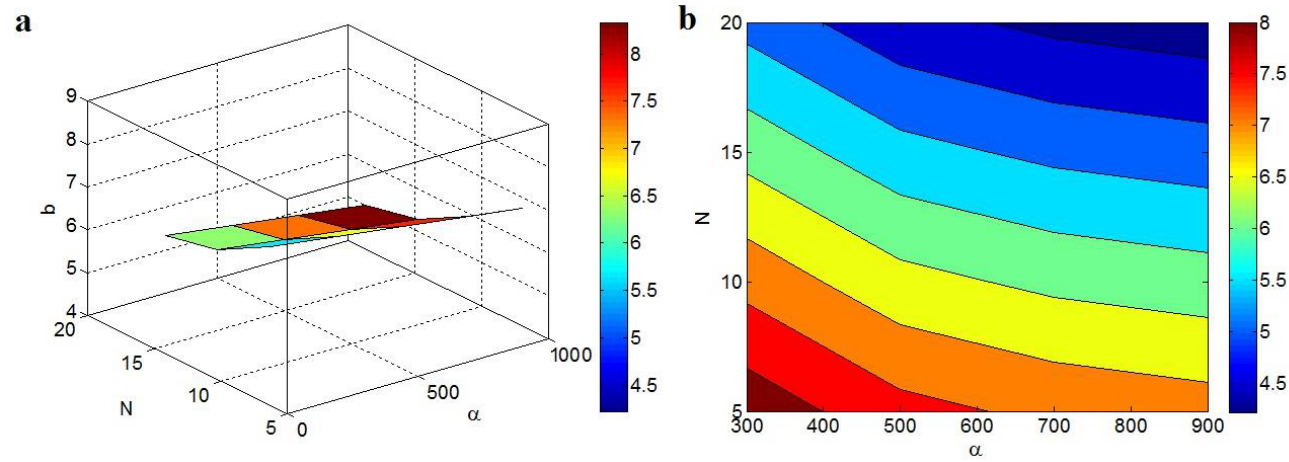
Figure 4. Variations in the “b” exponent at dissimilar grades of “ α ” and “N” and t i = 4 nm and d = 5 nm by ( a ) 3D and ( b ) 2D schemes.